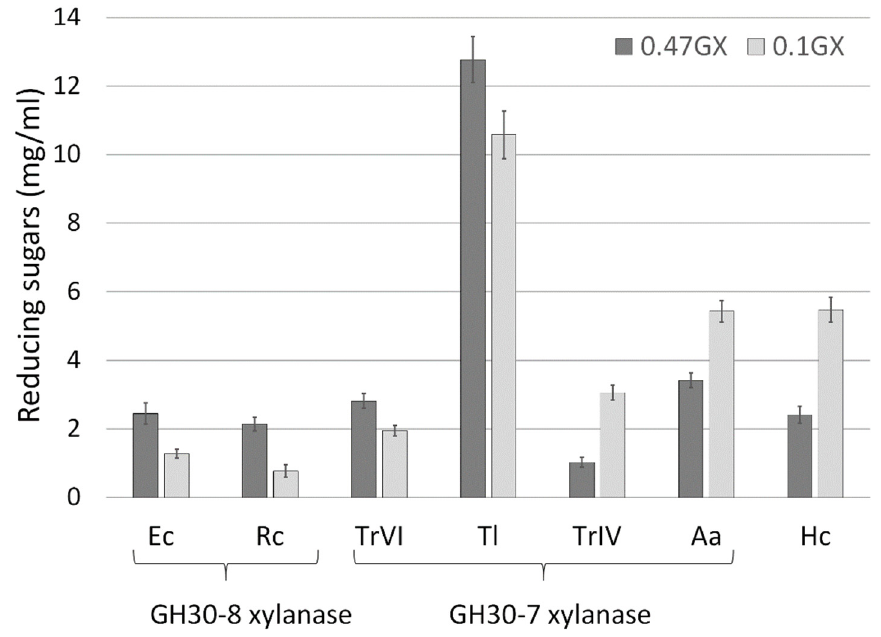
Figure 7. Final level of reducing sugars released from beechwood GXs containing 0.47 µmol MeGlcA/mg (0.47GX) or 0.1 µmol MeGlcA/mg (0.1GX) by GH30 xylanases. The substrates were incubated with a high load of the enzymes for 7 days.